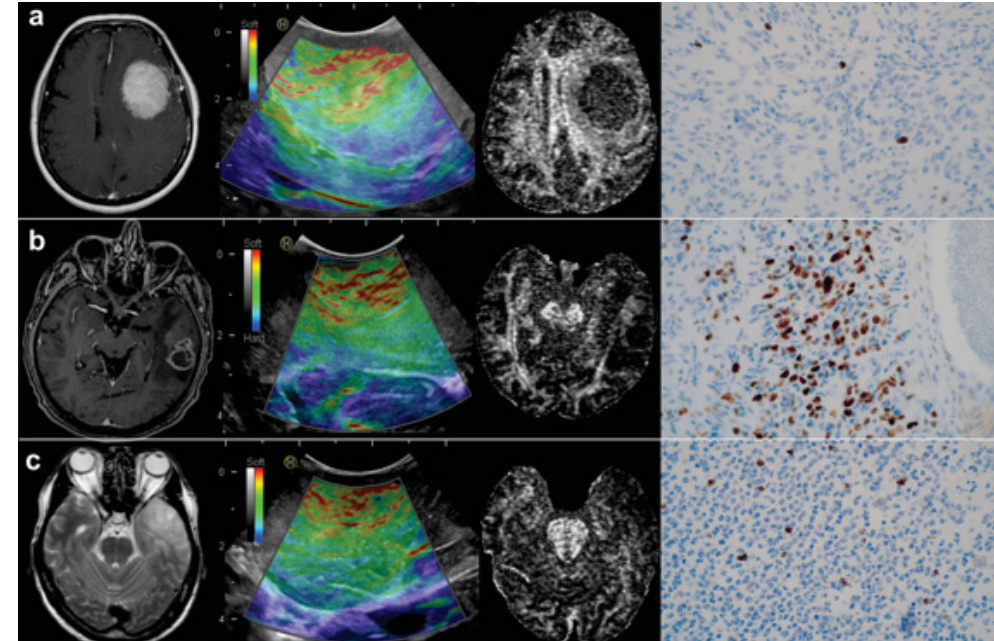
Figure 3. Illustrative cases of histopathological groups: ( a ) 75-year-old woman with a left frontal meningioma; ( b ) 56-year-old man with a left temporal low-grade glioma; and ( c ) 54-year-old man with a left temporal glioblastoma. From left to right: Axial T1-weighted post contrast slices for glioblastoma and meningioma and T2-weighted for low-grade glioma; ultrasound elastography images; fractional anisotropy maps; and immunohistochemical staining of Ki-67 at × 40 magnification.